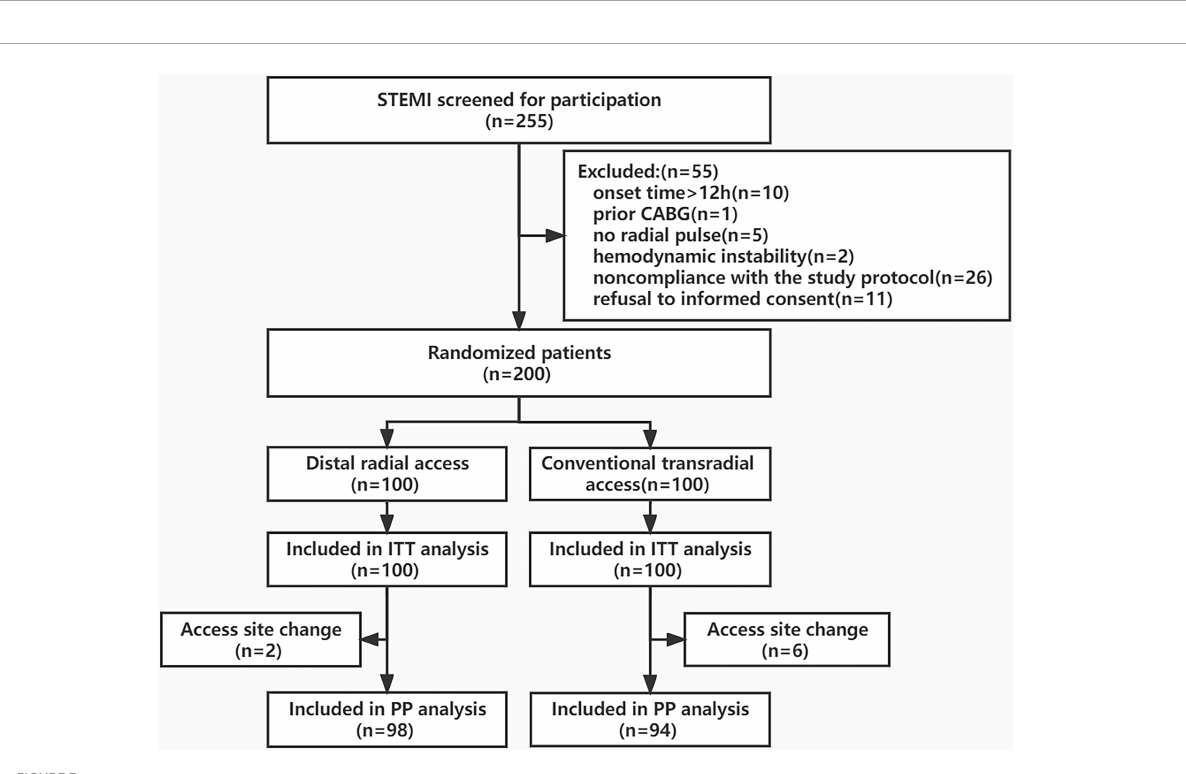
FIGURE3 Study flowchart. STEMI, ST-segment elevation myocardial infarction; CAGB, coronary artery bypass graft; ITT, Intention-to-Treat; PP,